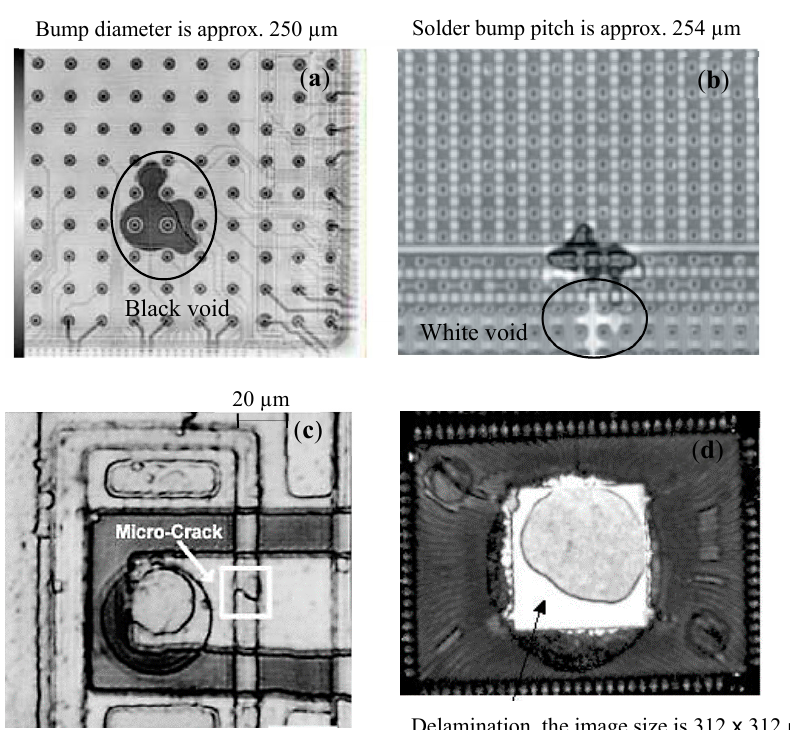
Figure 9. Various types of defects detected by SAM: ( a ) Black void below underfill level, ( b ) White void above underfill [19], ( c ) Micro-crack at wafer level, and ( d ) Delamination between the die top and the encapsulates [49].